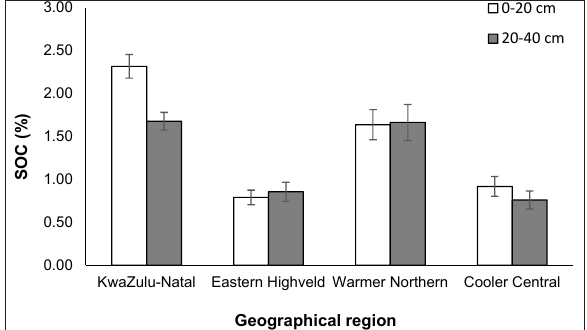
Figure 2 : Soil pH and organic carbon (SOC) variation (mean±s.e.) with crop rotation across different geographical regions of South Africa.